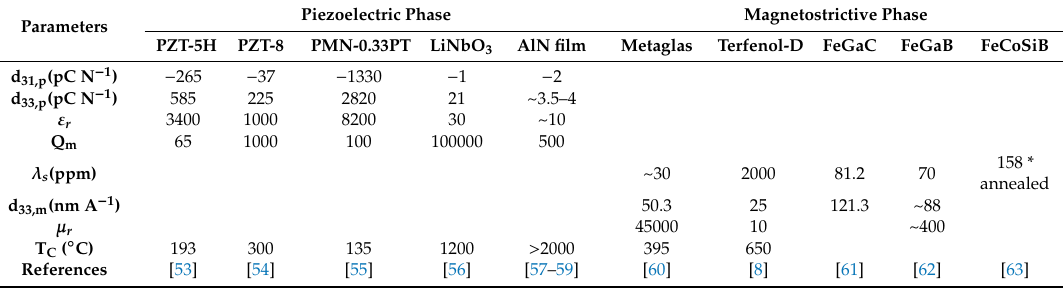
Figure 1. The year number of papers published on the multiferroic, magnetoelectric and magnetoelastic. Table 2. Parameters of typical piezoelectric and magnetostrictive materials.